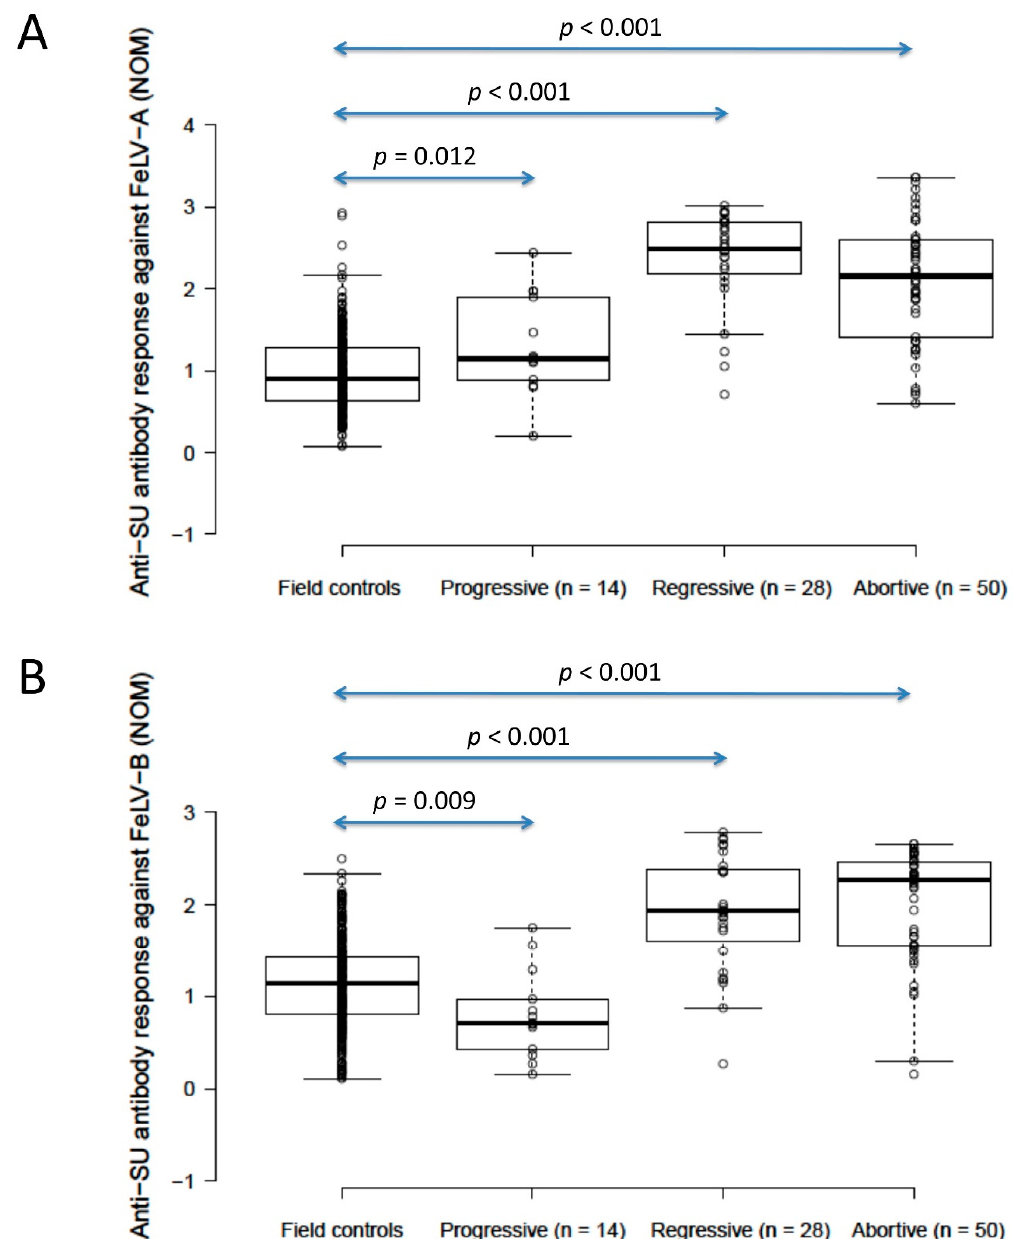
Figure 3. Comparison of anti-SU antibody ELISA responses to examine the effect of FeLV exposure/infection (( A ) anti- FeLV-A SU antibody ELISA results, ( B ) anti-FeLV-B SU antibody ELISA results). Anti-SU ELISA results likely reflect differences between groups with regard to virus-neutralising antibody (NAb) titres. The field control group consisted of unvaccinated and unexposed cats ( n = 303). The FeLV-infected cats consisted of presumptively progressive infections ( n = 14) and presumptively regressive infections ( n = 28). The abortive group (uninfected/exposed; n = 50) consisted of cats vaccinated with Fel-O-Vax ® 5 ( n = 29), cats vaccinated with Fel-O-Vax ® Lv-K ( n = 14) and FeLV-unvaccinated cats ( n = 7). Statistically significant differences in median NOD values are shown (Mann–Whitney U -tests). Data points are plotted as open circles, centre lines show the medians, box limits indicate the 25th and 75th percentiles, and whiskers extend 1.5 times the interquartile range from the 25th and 75th percentiles. Results from vaccinated cats are shown in Figure 4. NOD = normalised optical density, SU = surface unit.